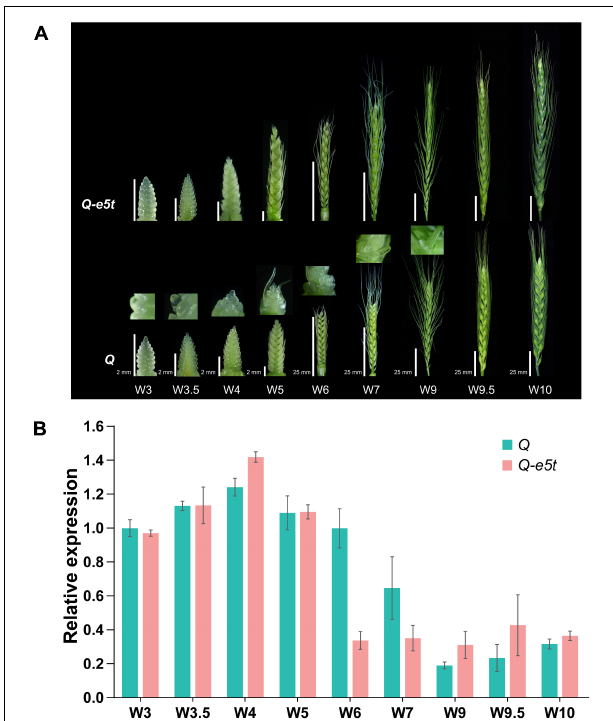
FIGURE 6 | Phenotypes and relative expression levels during young spike development. (A) The phenotypes of young spikes at the Waddington scale W3, W3.5, W4, W5, W6, W7, W9, W9.5, and W10. Bars, 2 mm (W3, W3.5, W4, and W5) and 25 mm (W6, W7, W9, W9.5, and W10). je0275 and WT exhibited the same bars at the same scale. (B) The relative expression levels of the Q and Q-e5t alleles from stages W3 to W10 were measured by qRT-PCR. The data are presented as the mean, and the error bars indicate the